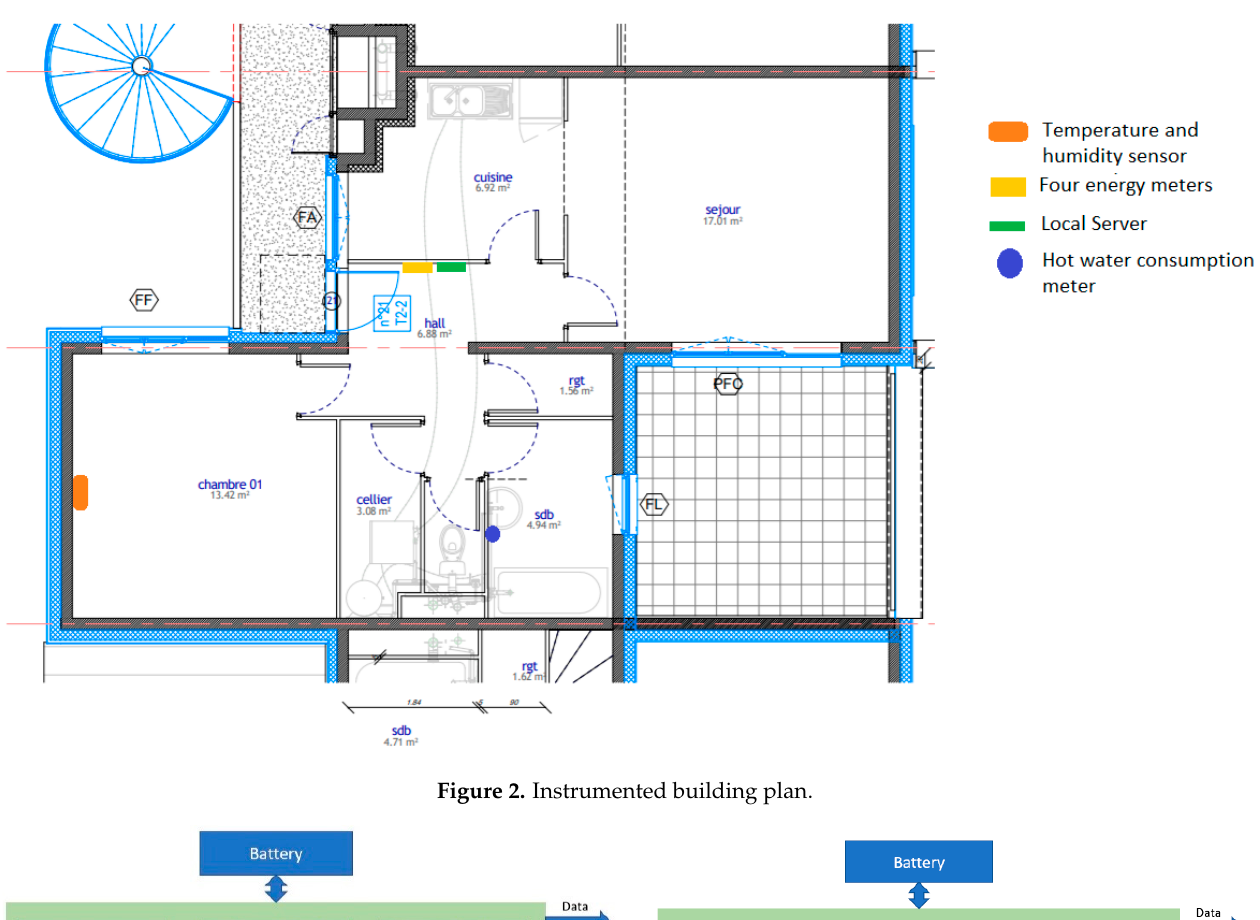
Figure 2. Instrumented building plan.